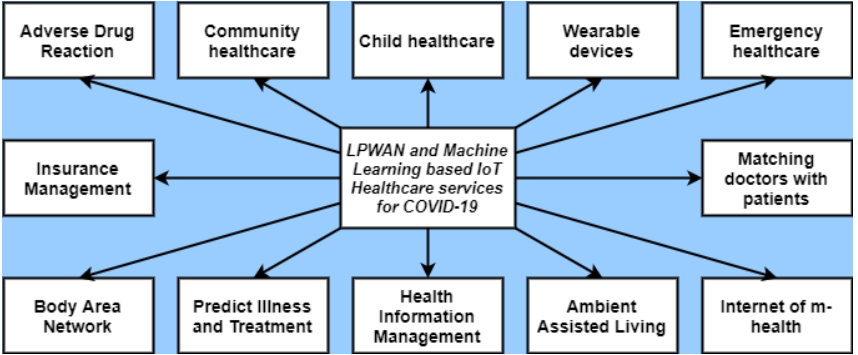
Figure 4. Healthcare services for